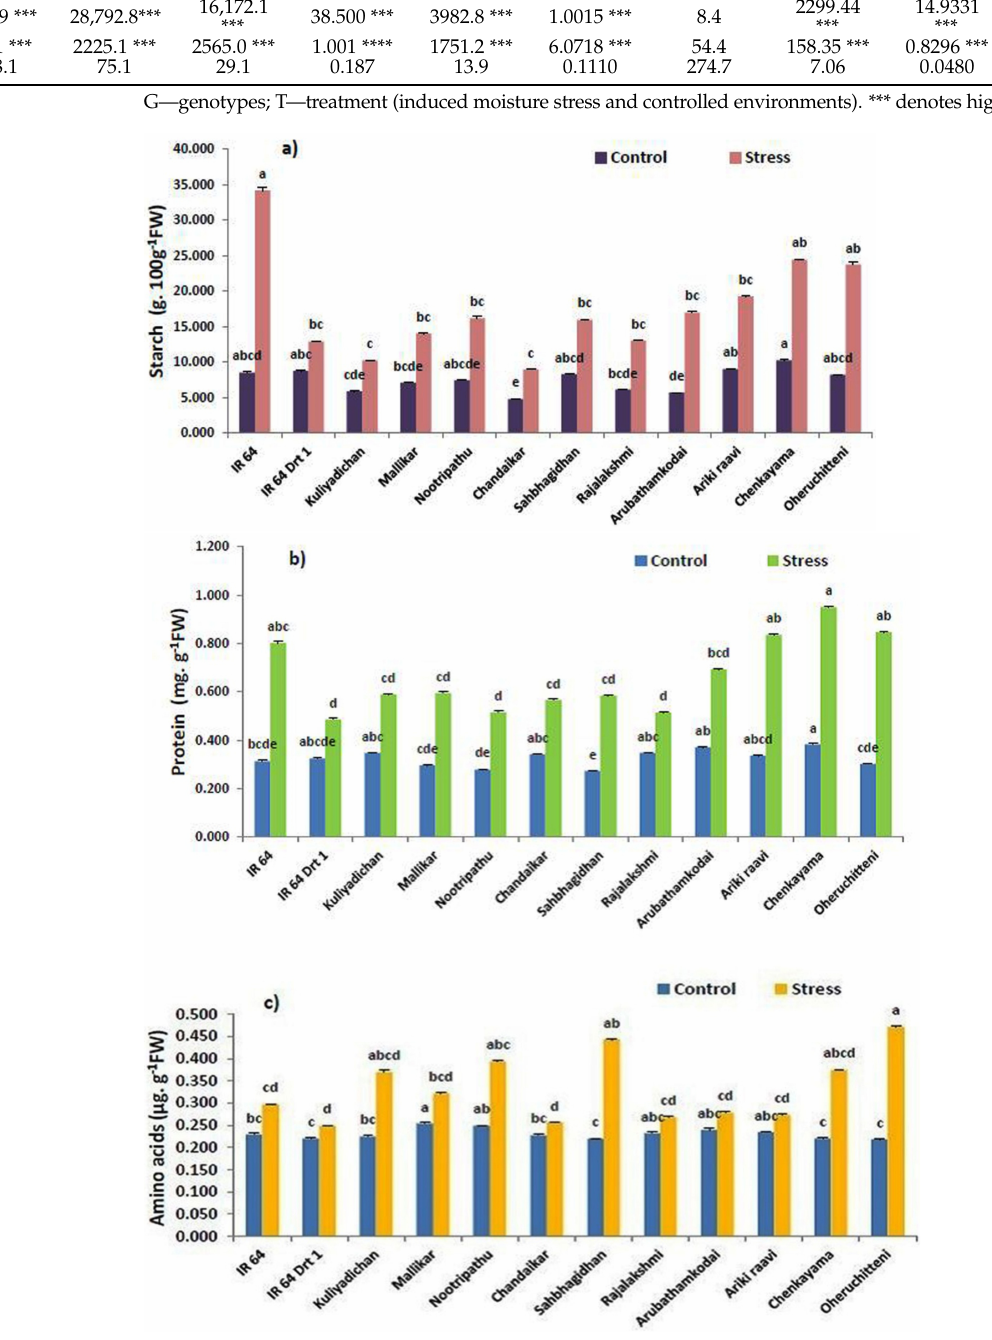
Figure 2. Influence of moisture stress on ( a ) starch, ( b ) protein and ( c ) amino acid content in the germinated seeds on 5 DAI in selected rice genotypes. Data represented are mean ( ± standard error) ( n = 3), and values followed by the same lowercase letter are not significantly different from each other, as determined by DMRT ( p ≤ 0.05). IR 64 and IR 64 (Drt1) used as negative and positive check, respectively, and stress imposed at − 1.5